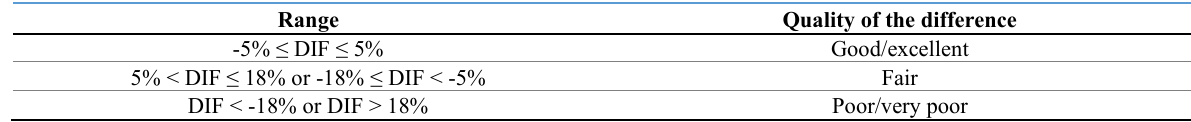
Table 5. Ranges of the differences for the classical reference model.